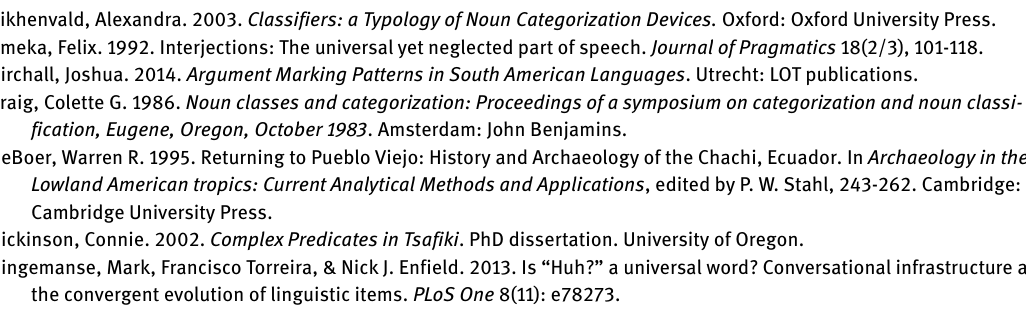
ACC accusative, AG.NMLZ agentive nominalizer, AUG augmentative, CAUS causative, CL classifier,